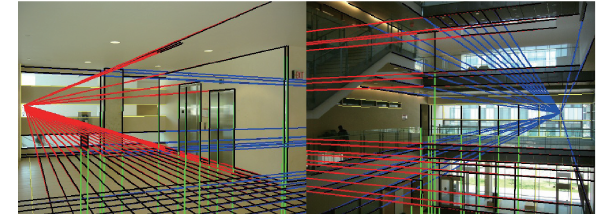
Figure 1. Structural lines in an indoor environment. The structural lines often have strong structural regularity, which are consistent with the Cartesian coordinate system, and can be extended to three principal directions (Han et al., 2021).